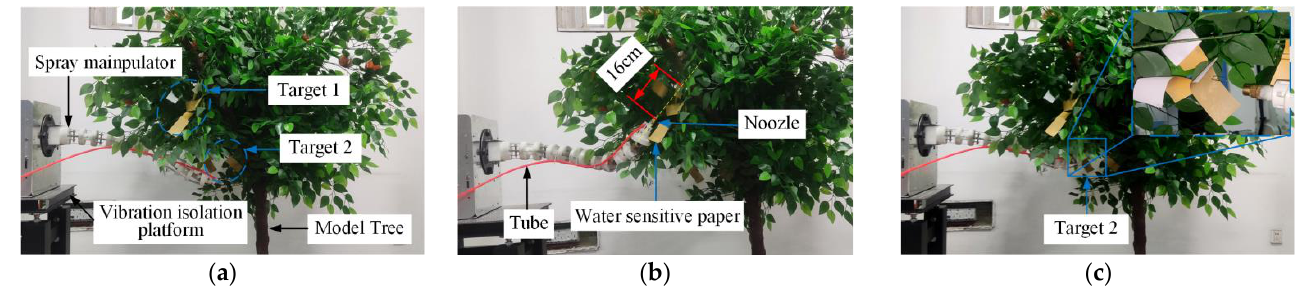
Figure 13. The three states of the spray manipulator in spraying operations: ( a ) initial state of the spray manipulator; ( b ) spraying state of the spray manipulator for target 1; ( c ) spraying state of the spray manipulator for target 2.